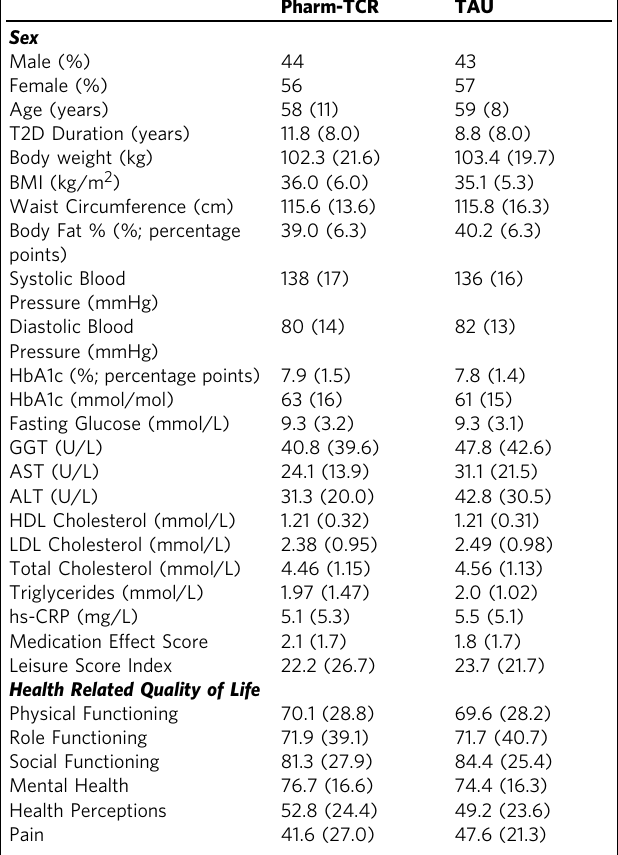
Table 1 Baseline characteristics.